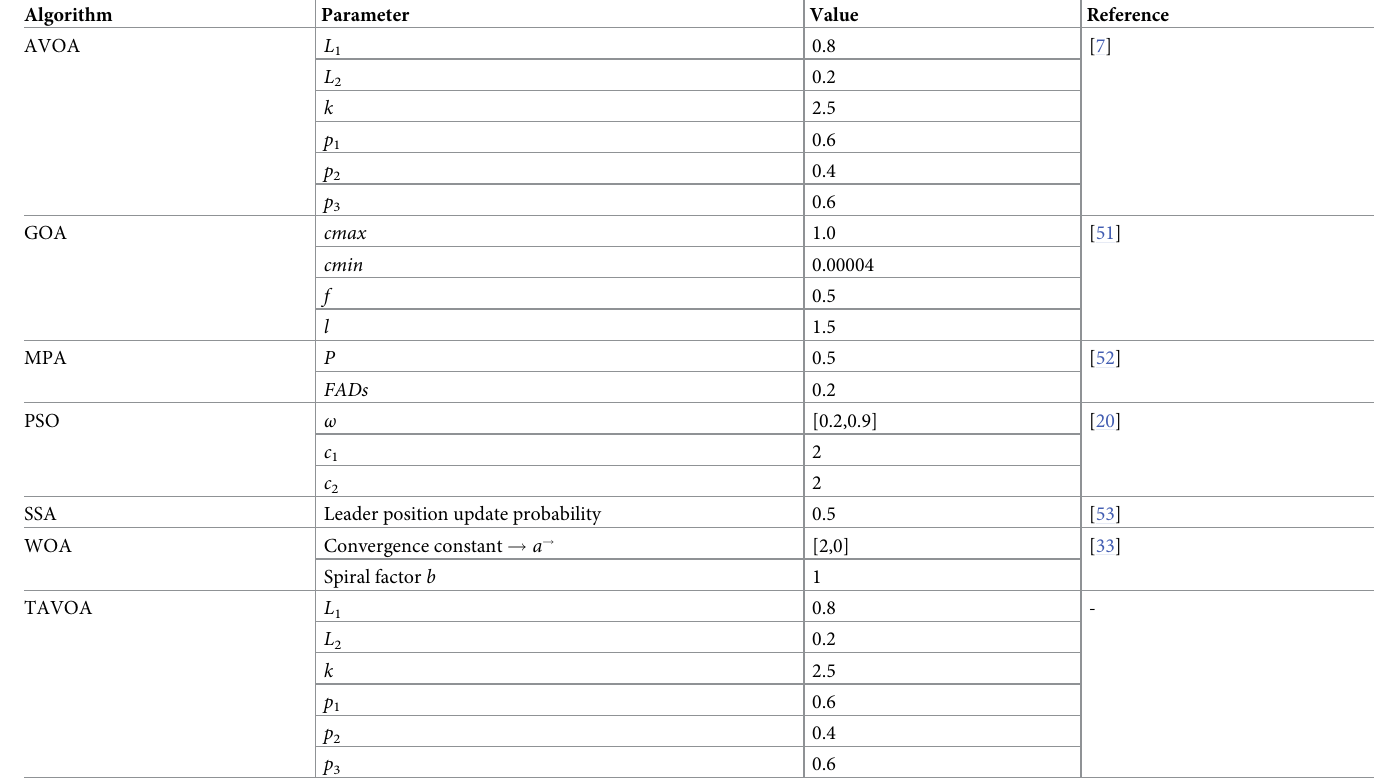
Table 1. The parameters setting of all comparison algorithms.